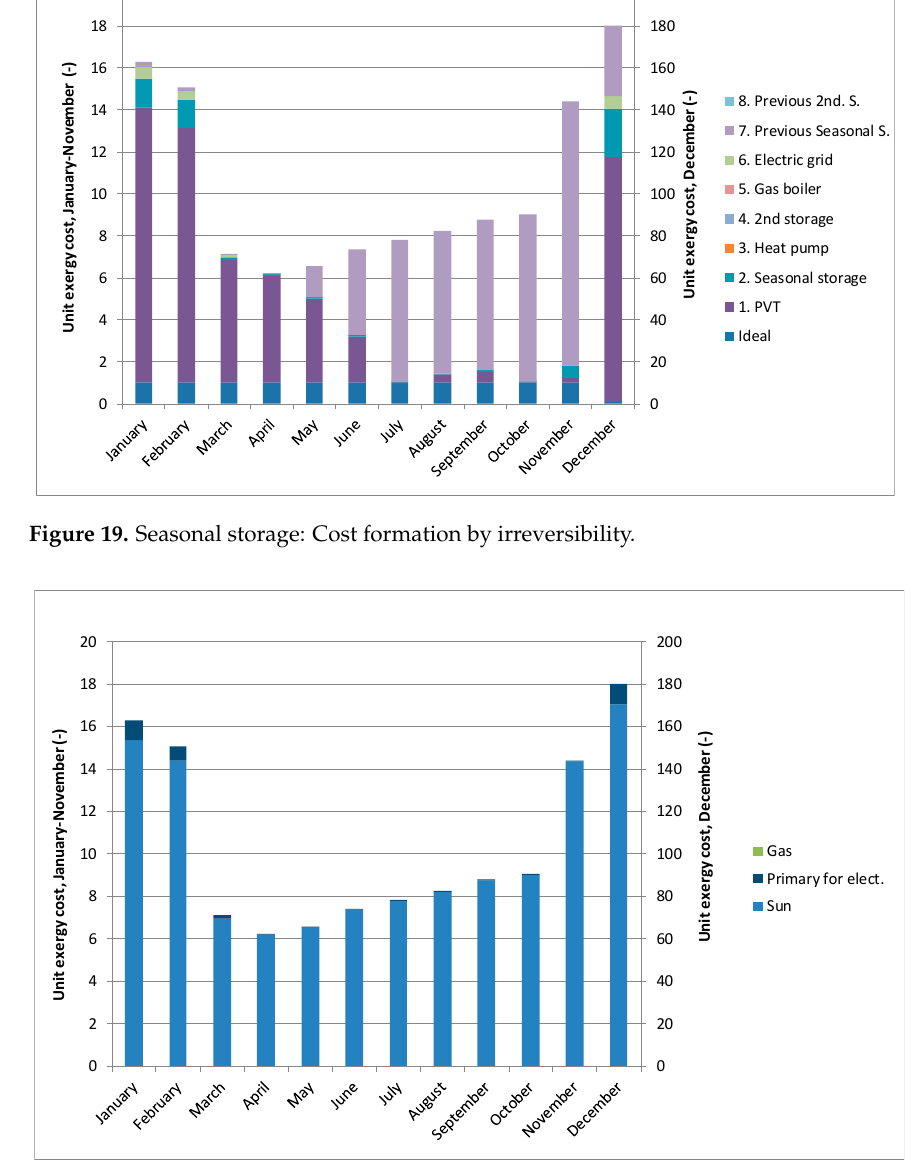
Figure 20. Seasonal storage: Cost formation by source.